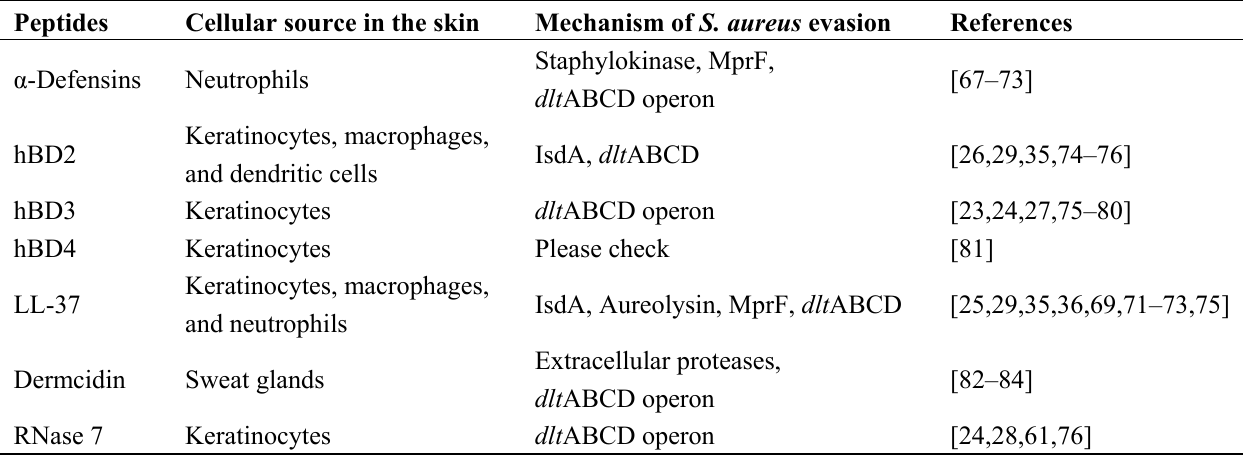
Table 1. Cationic antimicrobial peptides (CAMPs) that contribute to human cutaneous immune defenses against S. aureus